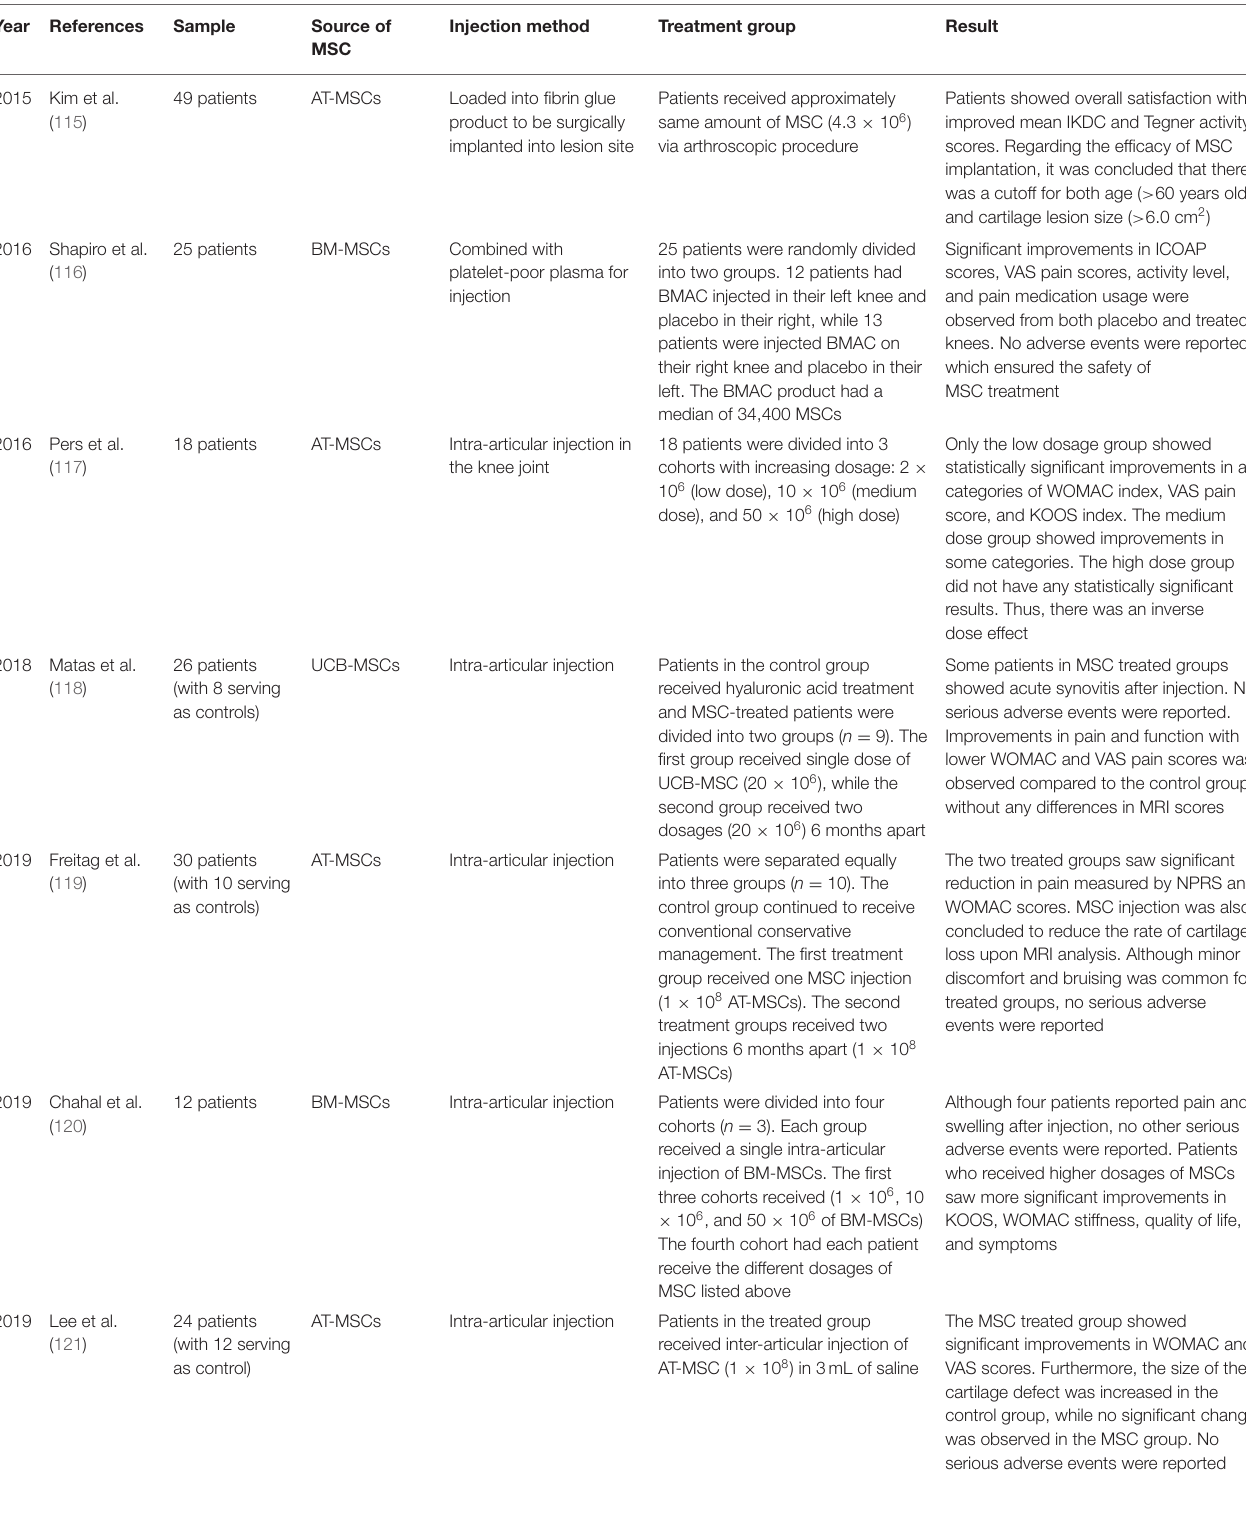
TABLE 2 | Clinical trials using MSCs in